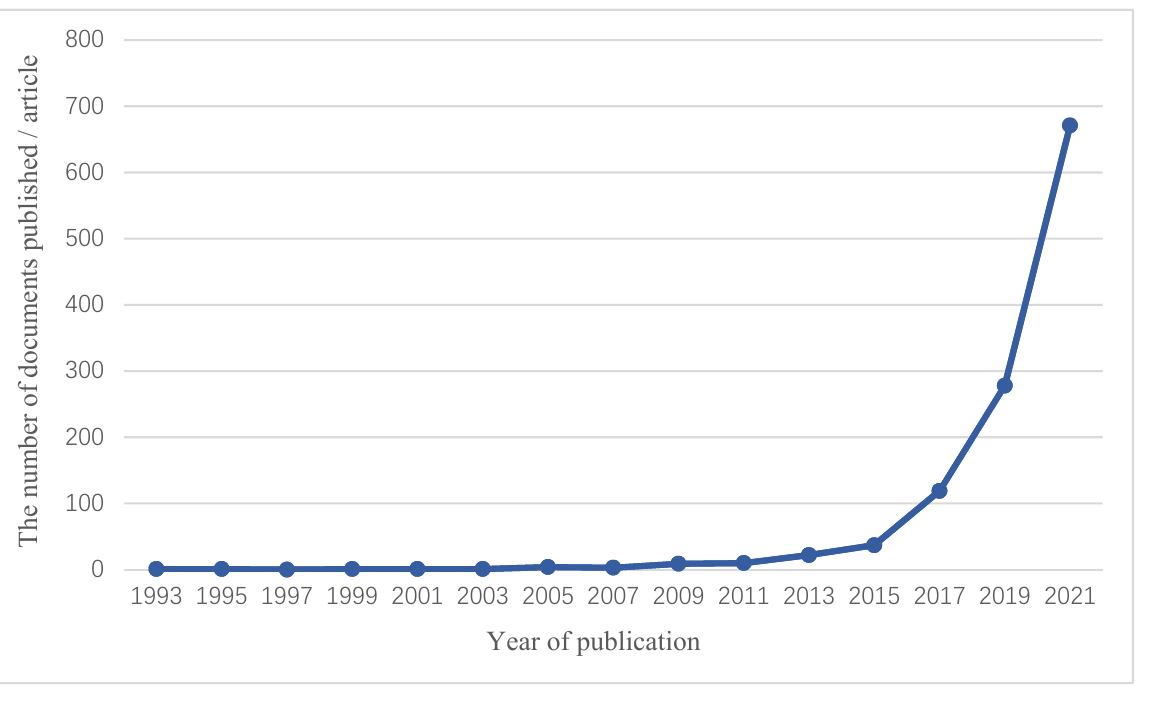
Figure 1. Number of RWS-related articles published over the years.